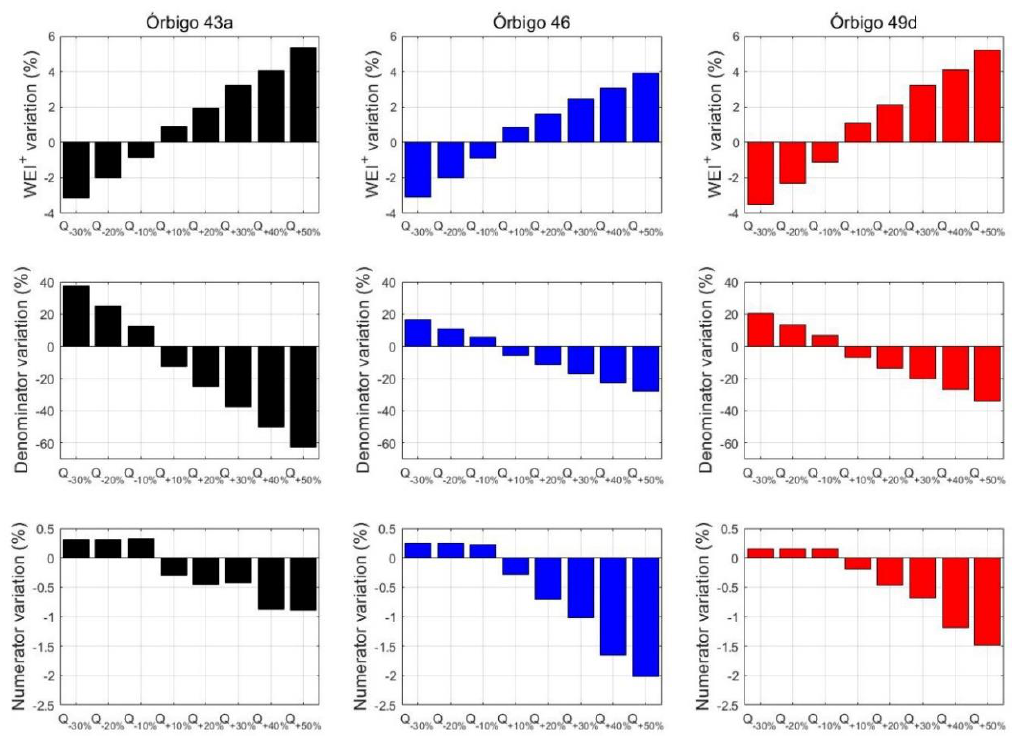
Figure 11. Variation of the WEI+, available water (WEI+ denominator) and consumed water (WEI+ numerator) induced by environmental flow scenarios in three river stretches in the upper (Ó rbigo 43a), middle (Ó rbigo 46) and lower (Ó rbigo 49d) parts of the basin (Figure 3).